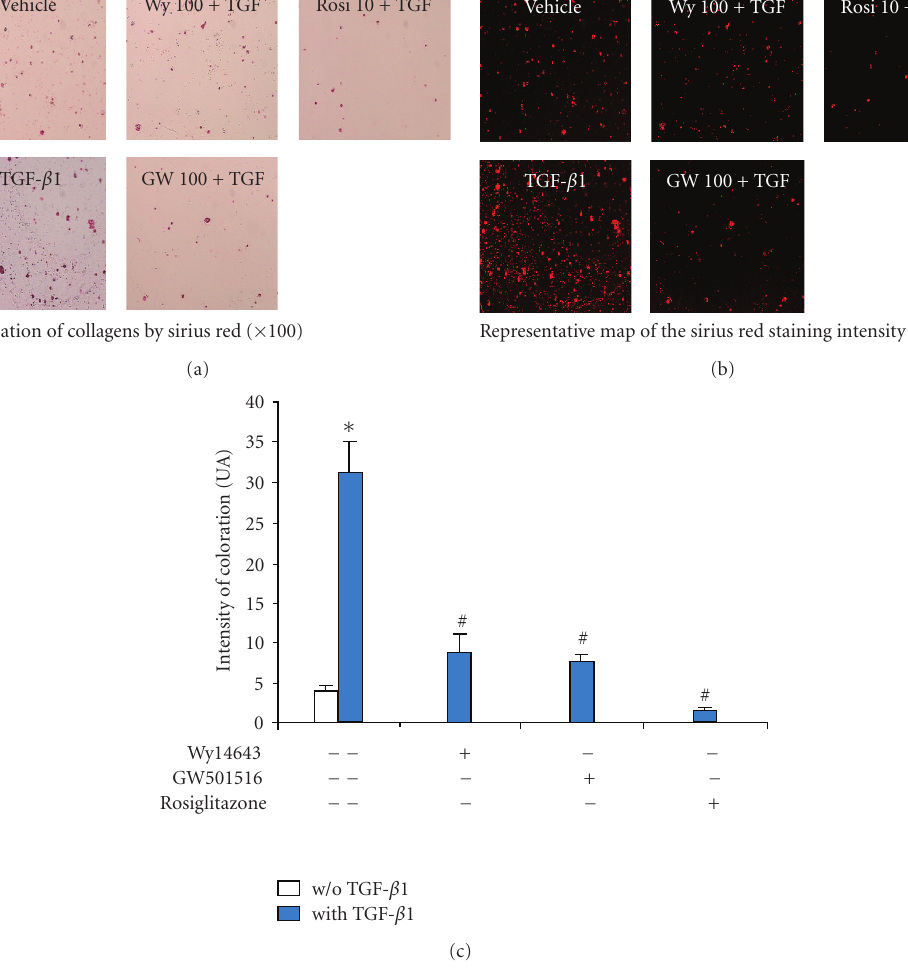
Figure 2: E ff ects of selective PPAR agonists on TGF- β 1-induced collagens metabolism in rat chondrocytes . Chondrocytes, embedded in alginate beads (5.10 4 cells per bead), were exposed to Wy14643 (100 μ M), GW501516 (100 nM), or rosiglitazone (10 μ M) for 2h before stimulation with TGF- β 1 (10ng/mL), in the presence or absence of PPAR agonists for 72 h. (a) Representative sections of Sirius red staining of beads ( n = 5, G: 100X); (b) Representative map of Sirius red staining intensity ( n = 5); (c) Mean overall quantification of Sirius red staining on beads sections ( n = 5). Data were expressed as mean ± SEM and statistically significant di ff erences from the control were indicated as ∗ P < . 05 and from TGF- β 1-treated cells as # P < .